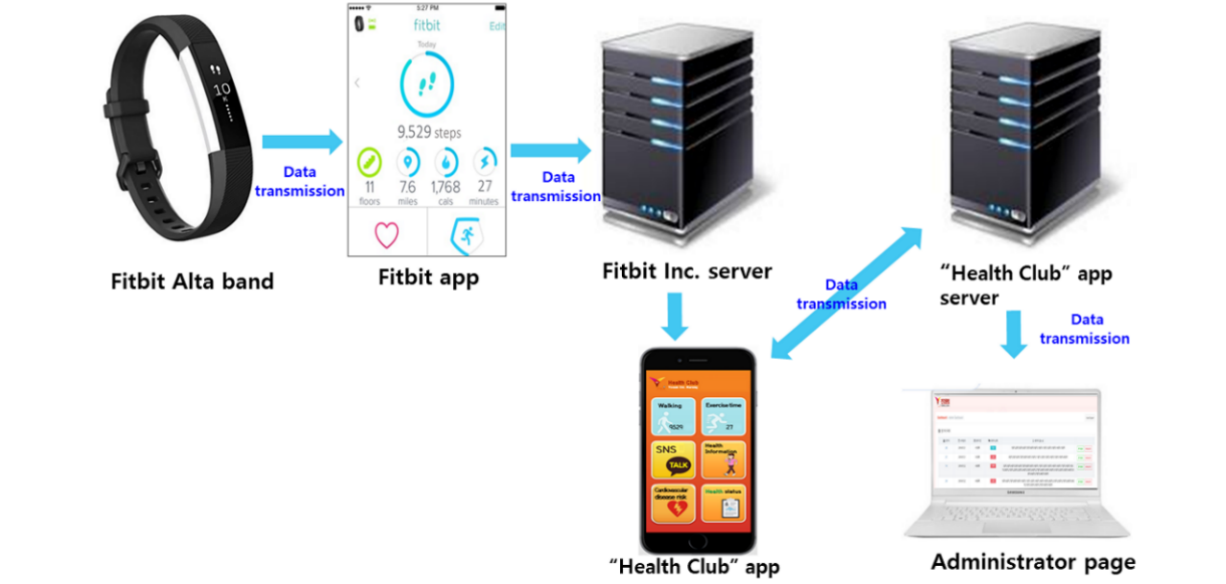
Figure 1. The process of mobile app